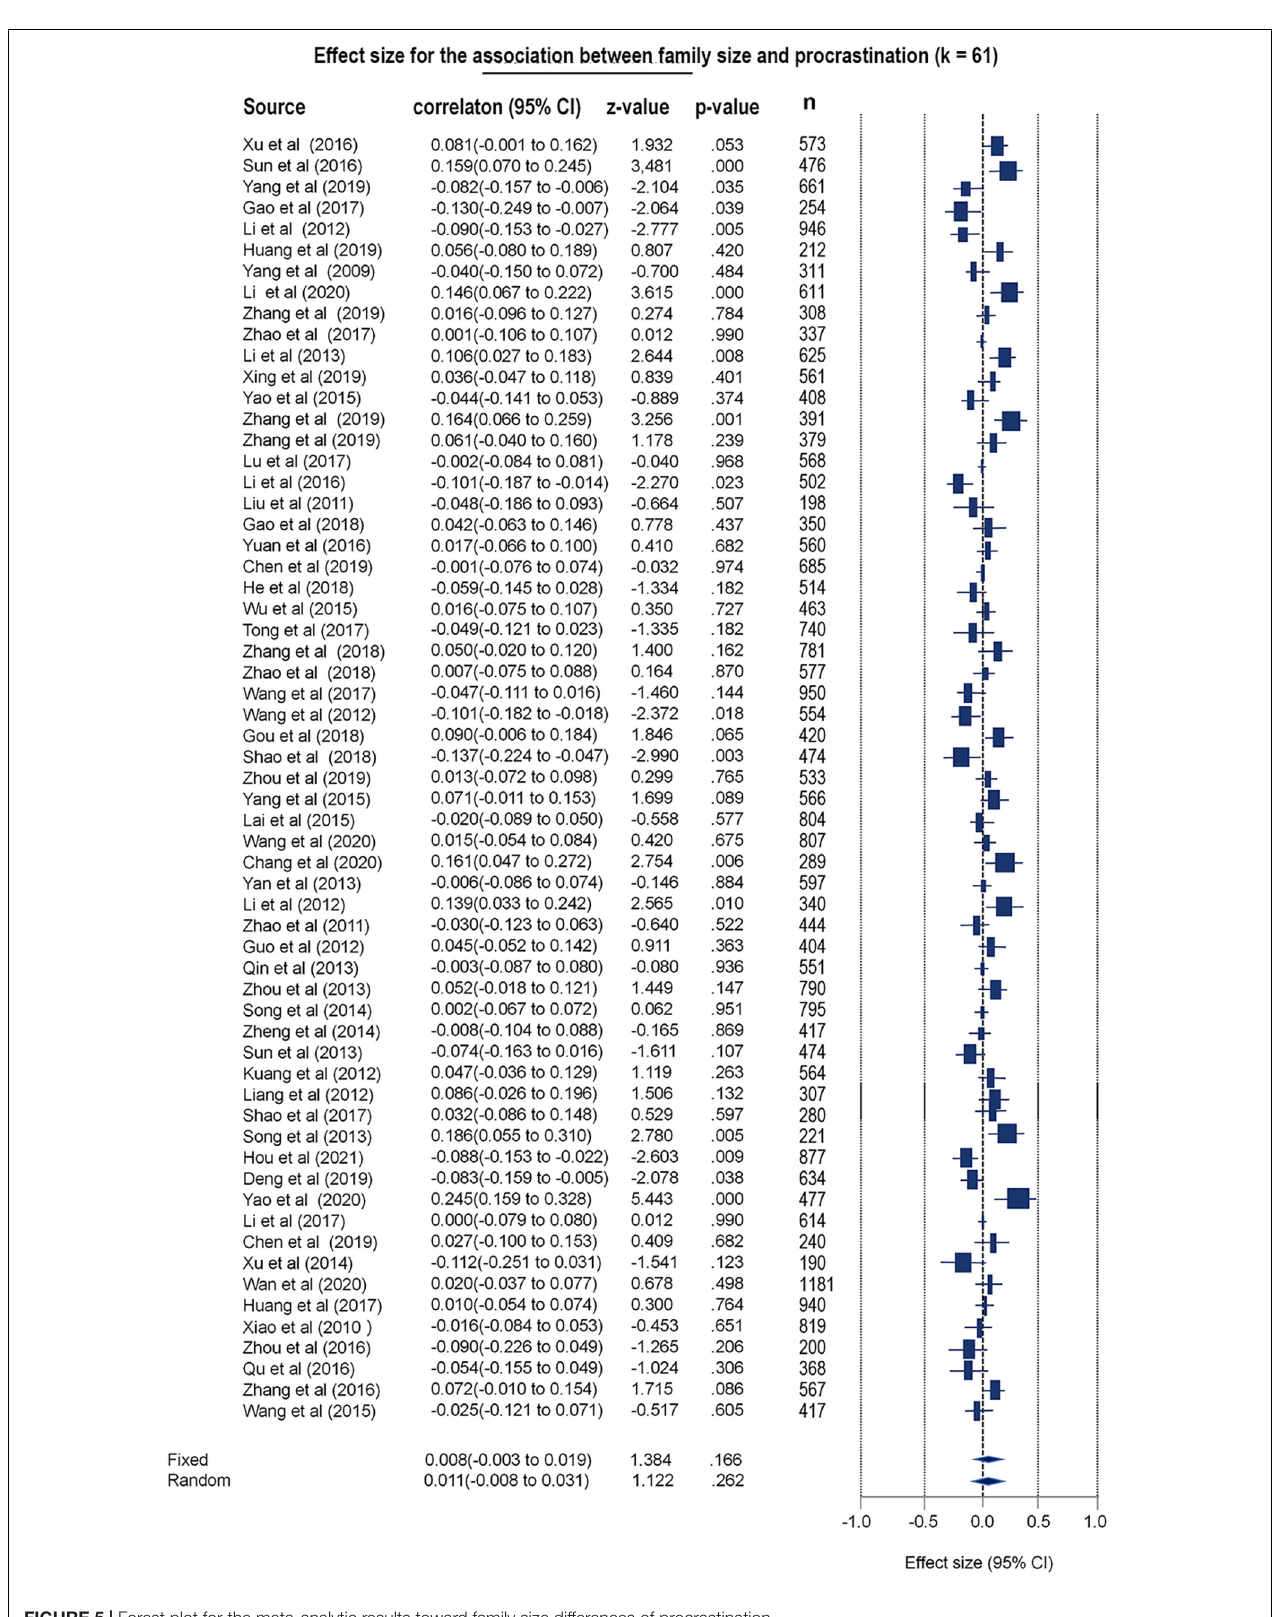
Frontiers in Psychology |